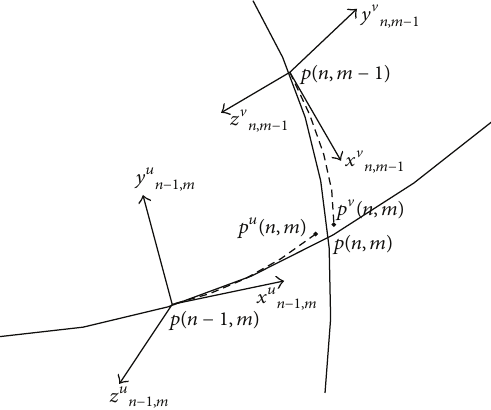
Figure 5: Coupling relationship between orthogonal coordinate